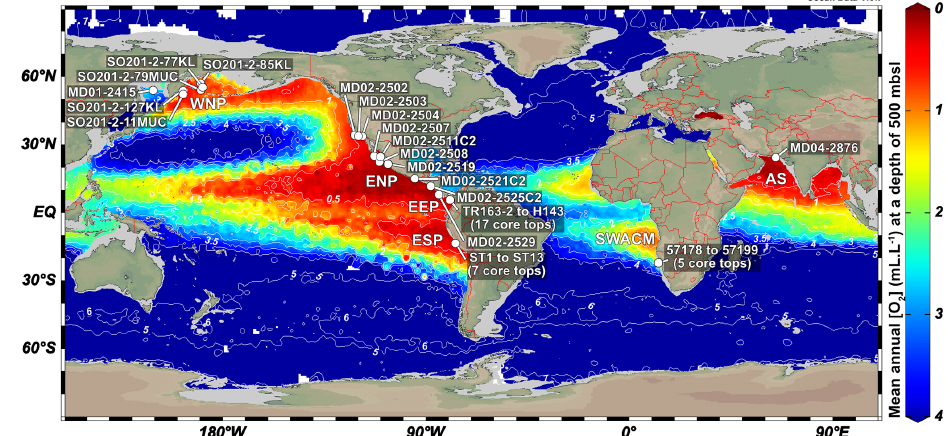
Figure 1. Location (white dot) of the different cores used in this study. Labels show core names. Depths and mean annual dissolved oxygen concentrations near core sites are available in Table 1. This figure was generated by using the Ocean Data View software (Schlitzer, 2020) and the World Ocean Atlas 2013 dataset (Garcia et al.,